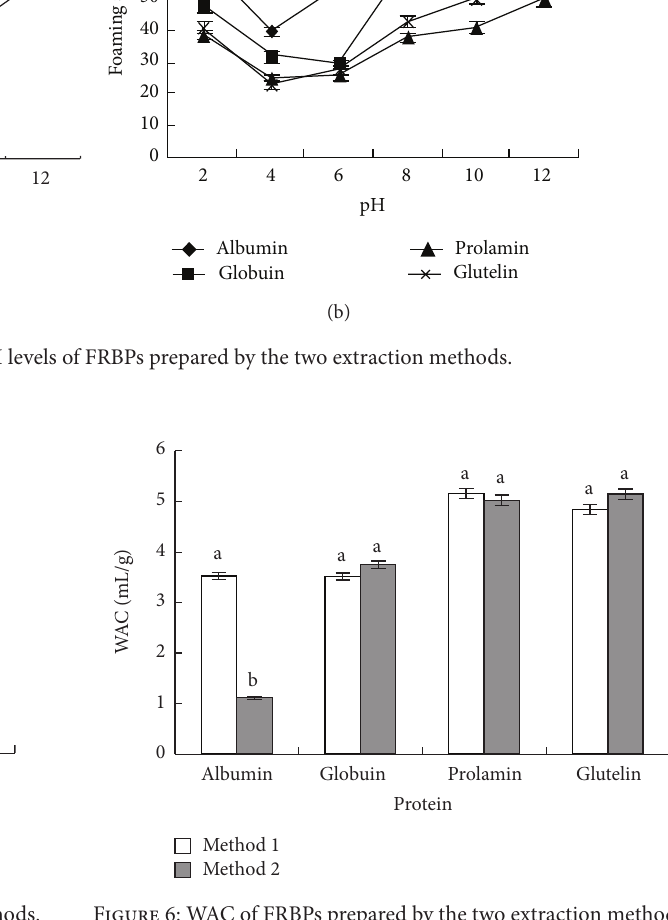
saccharide-protein complex is capable of forming a stable emulsion and foam because the side chain of the saccharide- protein complex improves the surface hydrophobicity of the protein molecule resulting in an increased interaction between the protein and water molecules. Thus, the apparent viscosity of the protein dispersion and the stability of the foam and emulsion are increased [21].